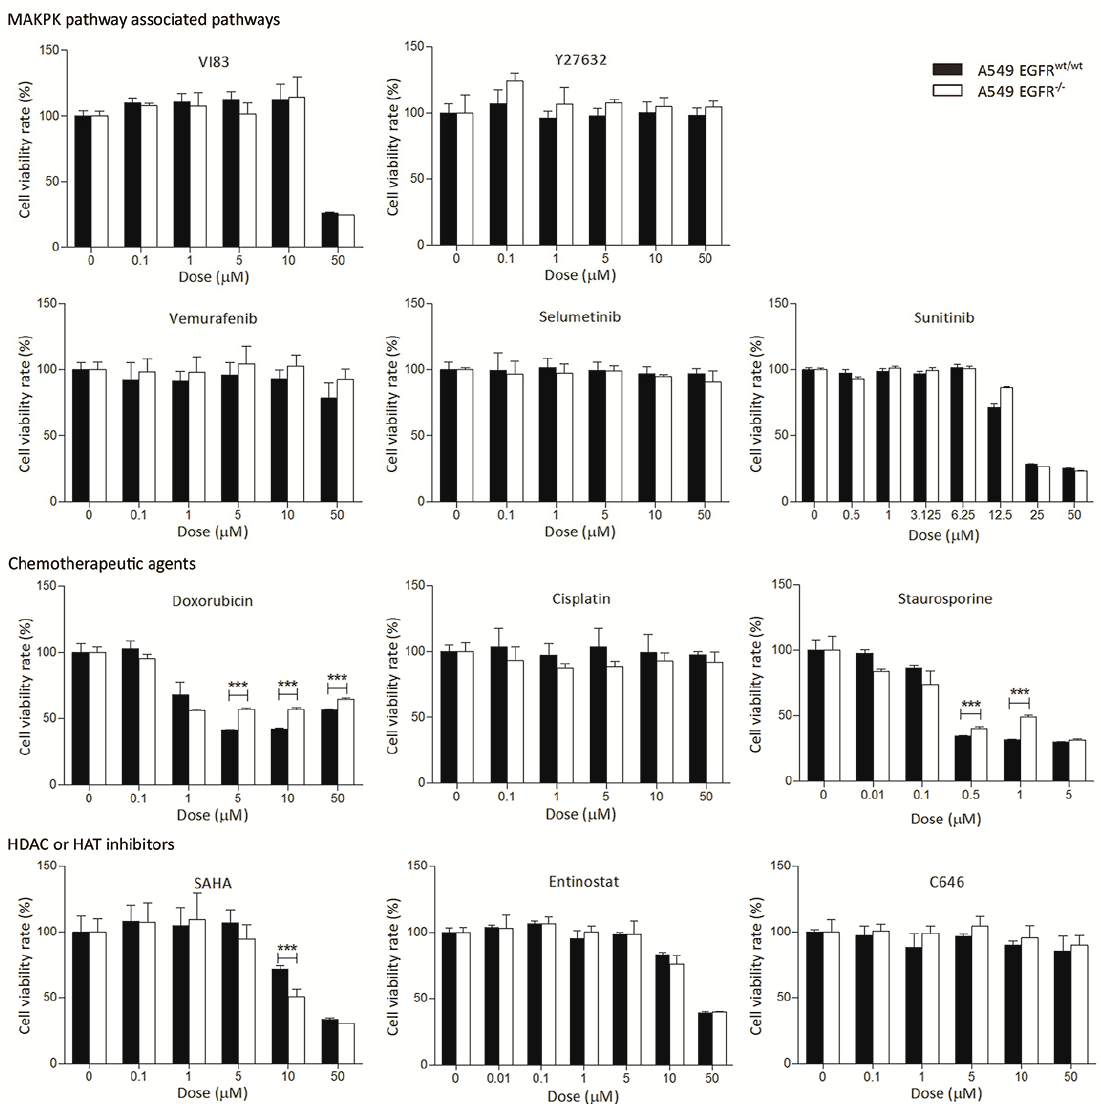
Figure 2. Treatment of the A549 EGFR wt/wt and EGFR − / − cells with different drugs. Cells were treated with drugs at indicated concentrations for 72 h and cell viability was determined with an MTS assay. For staurosporine, cell viability was determined after 24 h due to its toxicity. Data in bar graphs are represented as mean ± SD ( n ≥ 3); two-tailed unpaired student’s t -test: * p -values < 0.05; ** p -values < 0.01; *** p -values < 0.001; ns: not significant.